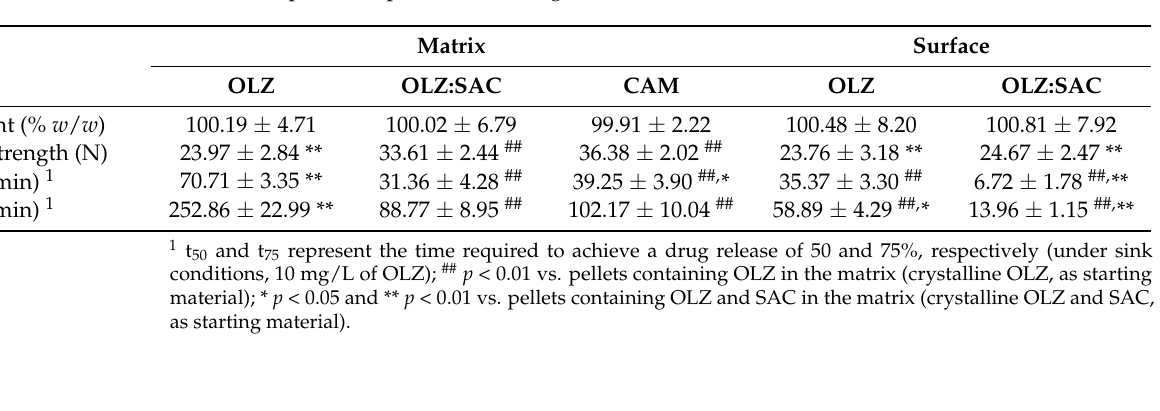
Figure 3. Fourier-transform infrared spectra of pure crystalline saccharin (yellow), pure crystalline olanzapine (orange), the physical mixture containing crystalline olanzapine and saccharin (green), and the co-amorphous system produced using both compounds (blue). Table 2. Properties of pellets containing OLZ, or OLZ and SAC, in the matrix or on the